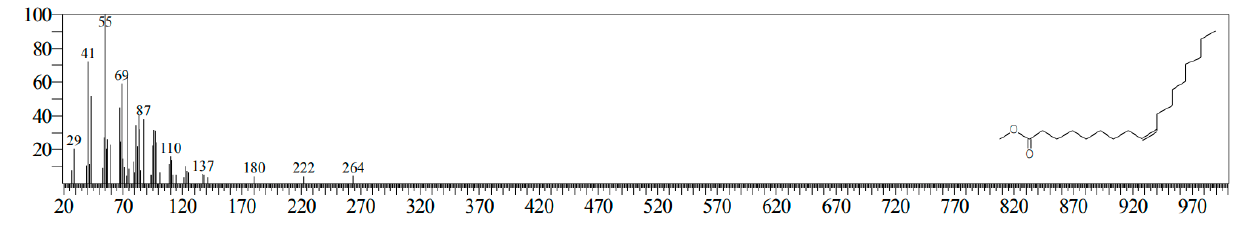
Figure 11. Comp Name: 9-Octadecanoic acid (Z)-, methyl ester, Run Time: 17.386, Mol Weight: 296.